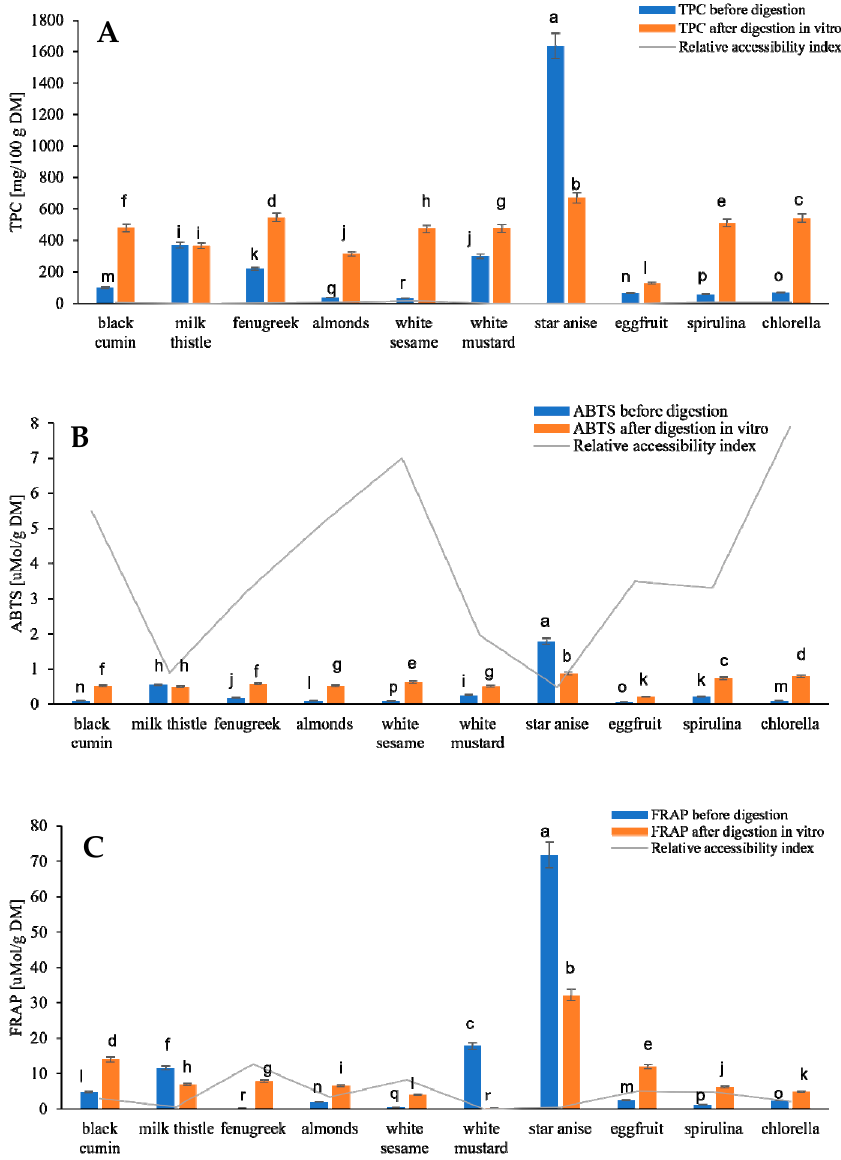
Figure 1. Total polyphenols content ( A ), antioxidant activity (ABTS+ ( B ); FRAP ( C )) and their potential bioaccessibility in the analyzed plant materials.